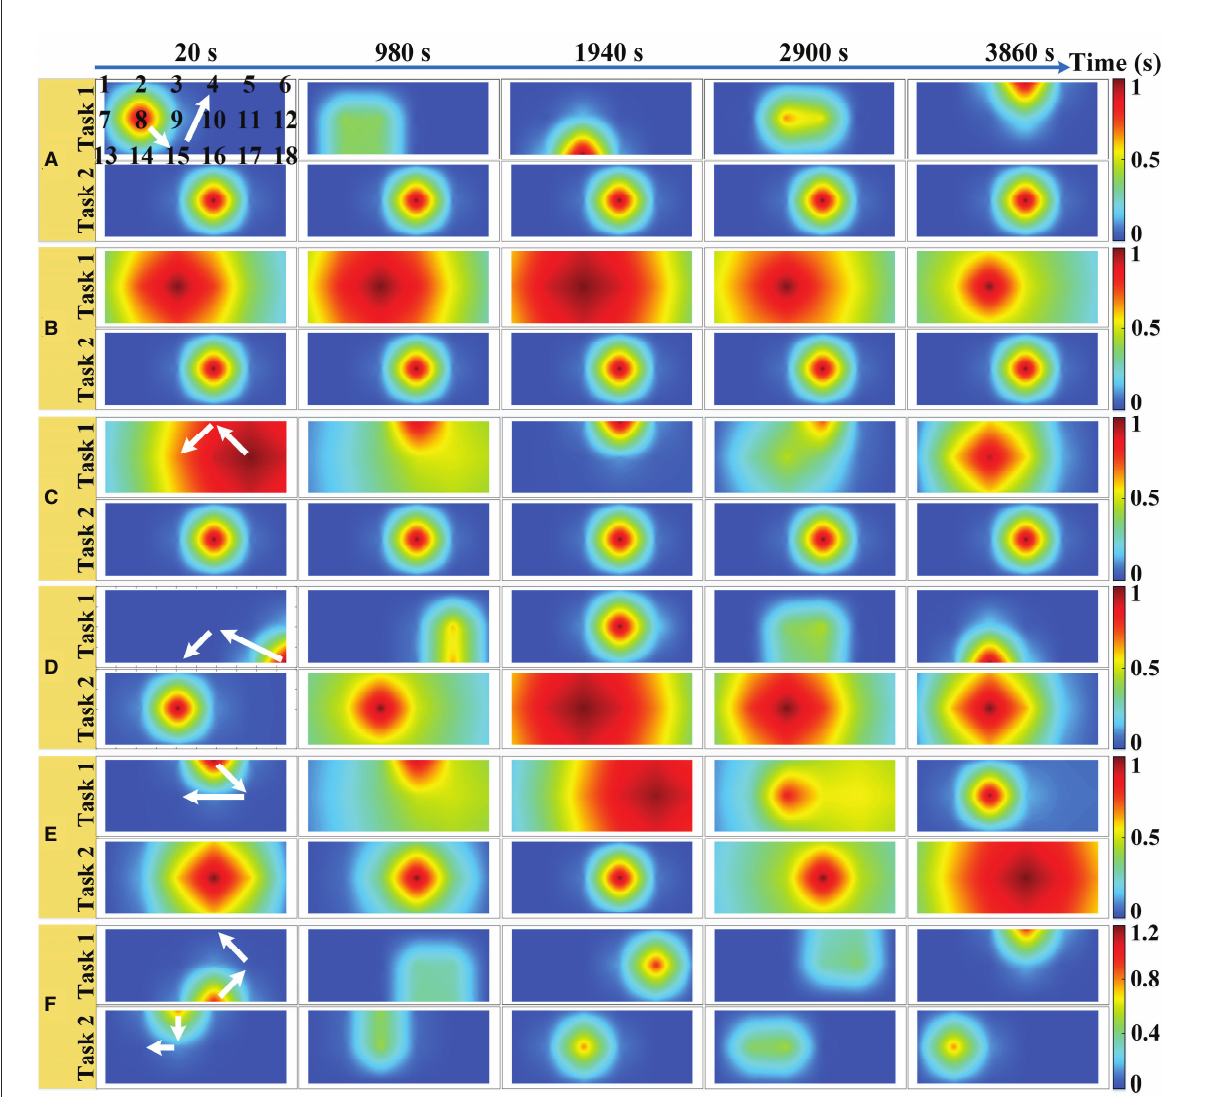
FIGURE2 Six simulations with random varying spatial patterns of brain activation in prefrontal regions: (A) The center of the activation region is the random walk but its size remains constant. (B) The size of the activation region varies randomly but its center remains the same. (C) Both the center and the size of the activation region change randomly with time. (D) The center of the task 1 evoked activation region randomly walks while the size of task 2 evoked activation region varies randomly. (E) Both the center and the size of the task 1 evoked activation region change randomly with time while the size of task 2 evoked activation region varies randomly. (F) The center of the activation region is random walk for both tasks, but the amplitude of the HRF for task 1 is randomly varying, while that of task 2 remains constant. The white arrows indicate the direction of linear movement of the center of the activation region. The black numbers indicate the location of the sampling channels.